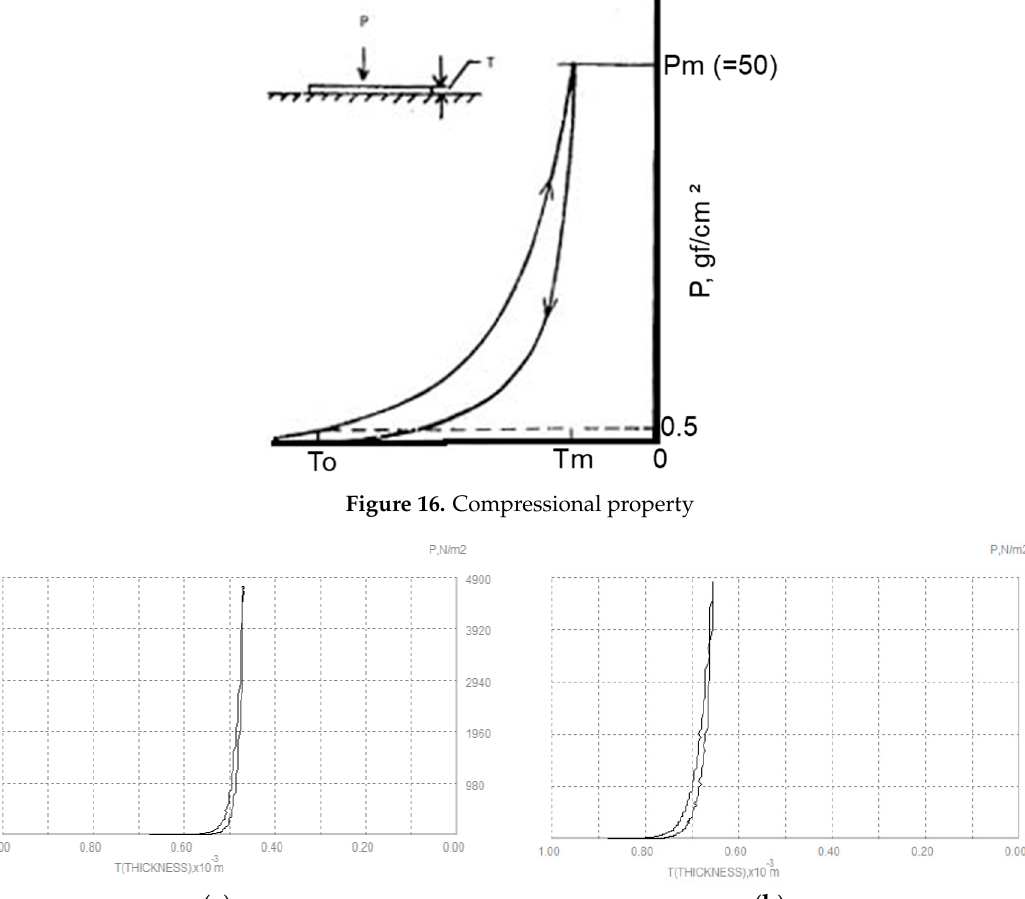
Figure 17. Compression property of ( a ) woollen fabric; ( b ) woollen fabric with interlining.